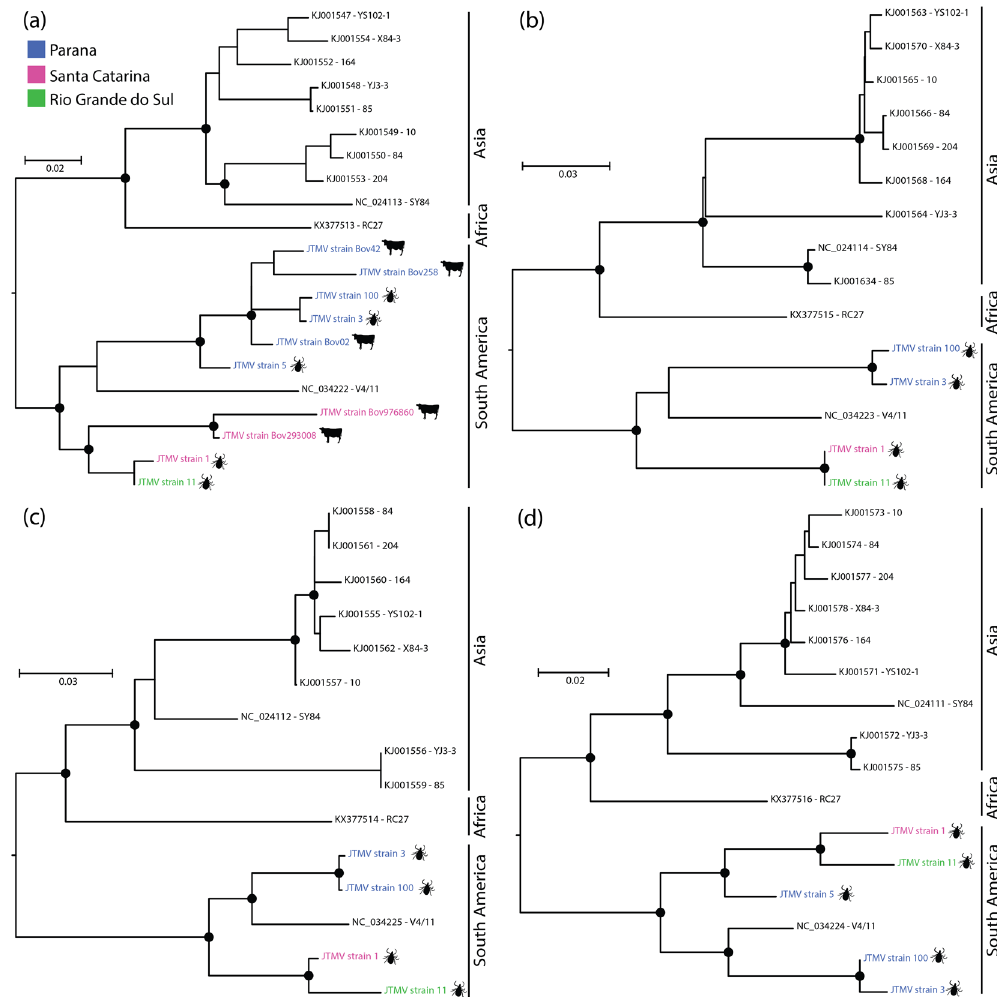
Figure 1. Maximum likelihood phylogenies of new strains of Jingmen tick virus. Phylogenies were constructed on nucleotides alignments, ( a ) segment 1 (NS5-like) based on TN + F + I nucleotides substitution model, ( b ) segment 3 (NS3-like) based on TIM3 + F + I nucleotides substitution model, ( c ) segment 2 (Glycoprotein) based on TIM3 + F + G4 nucleotides substitution model and ( d ) segment 4 (VP2-VP3) based on TNe + I nucleotides substitution model. Phylogenies are midpoint rooted for clarity of presentation. The scale bar indicates evolutionary distance in numbers of substitutions per nucleotides sites. Taxons are colored according to geographical location, and the hosts were denoted with a silhouette. The legends for the colors are shown on the left. The black circles indicate the main nodes with maximum likelihood bootstrap support levels above 75% bootstrap